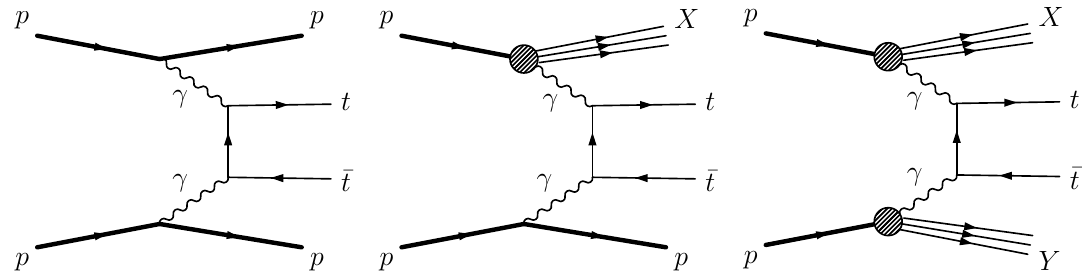
Figure 1 . Classes of processes discussed in the present paper. From left to right: elastic-elastic, inelastic-elastic (or equivalently, elastic-inelastic), and inelastic-inelastic